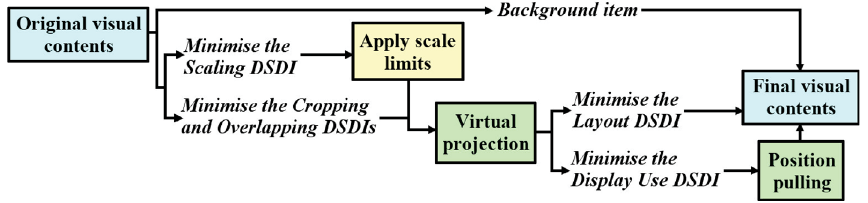
Fig. 5 Flowchart demonstrating navigation of the technique.